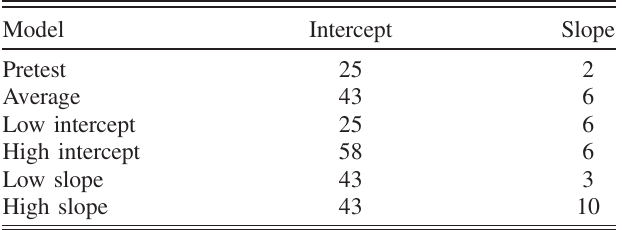
TABLE III. Model parameters used to simulate pretest and post-test score